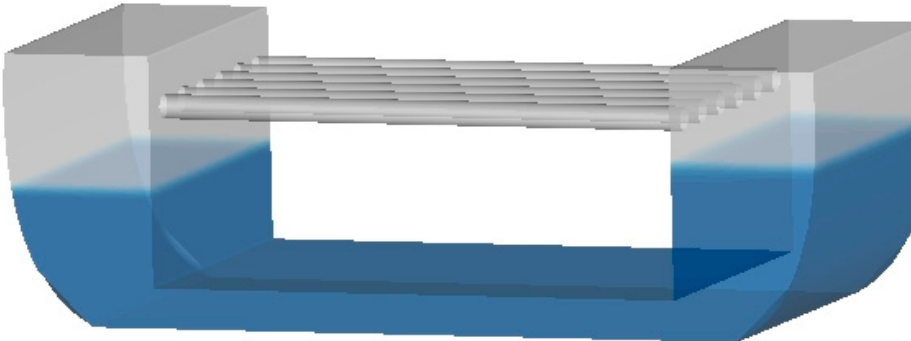
- The dimensionless damping coe ffi cient of the water tank n t is obtained by simulating